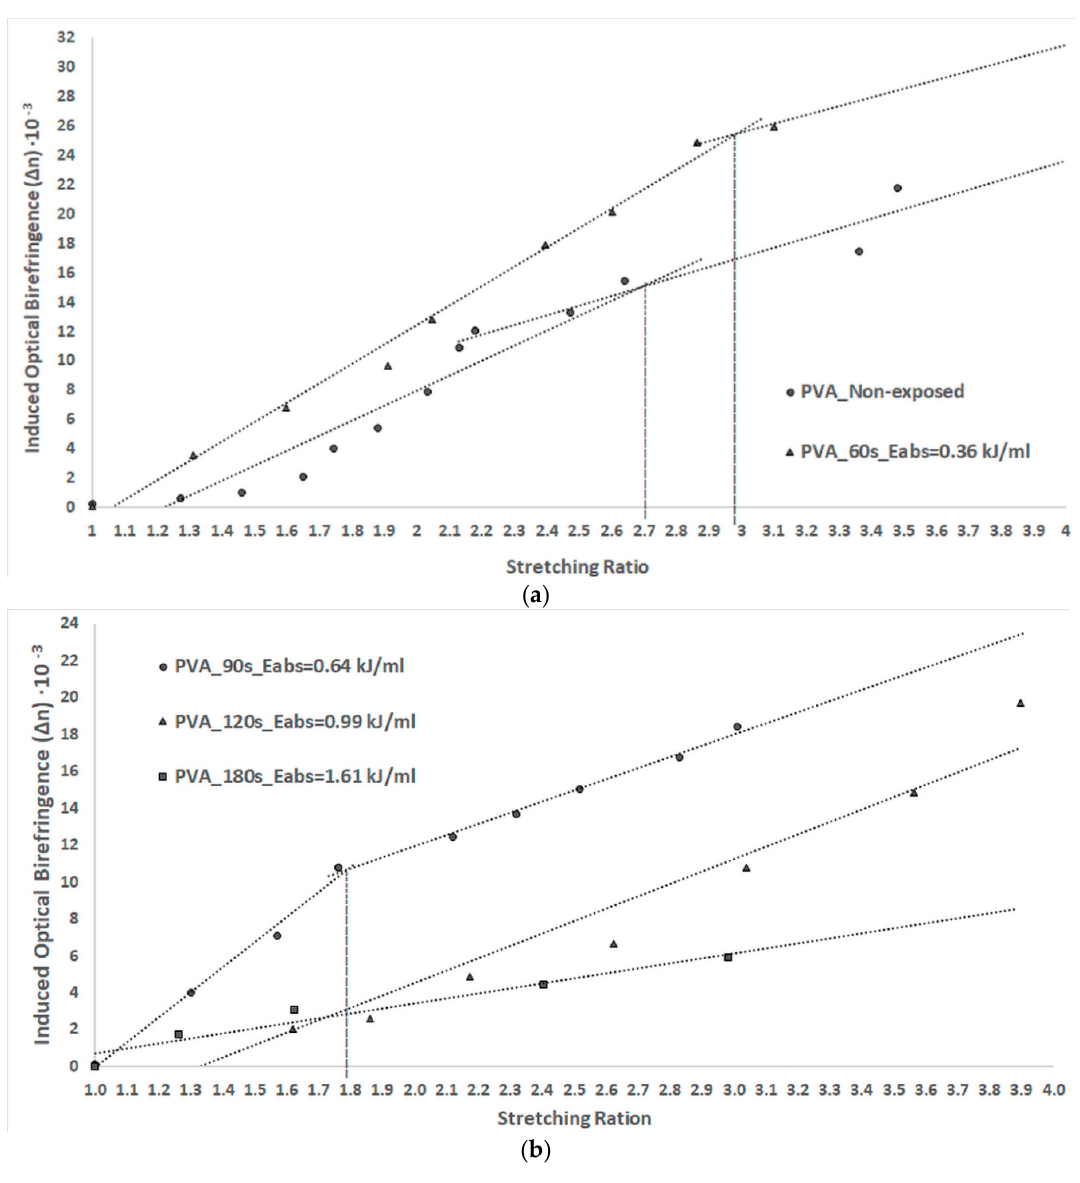
Figure 5. ( a ) Dependence of induced optical birefringence versus stretching ratio of PVA foils obtained before and after 60 s of MW irradiation; ( b ) Dependence of induced optical birefringence on the stretching ratio of PVA foils obtained after 90, 120, and 180 s of MW irradiation.